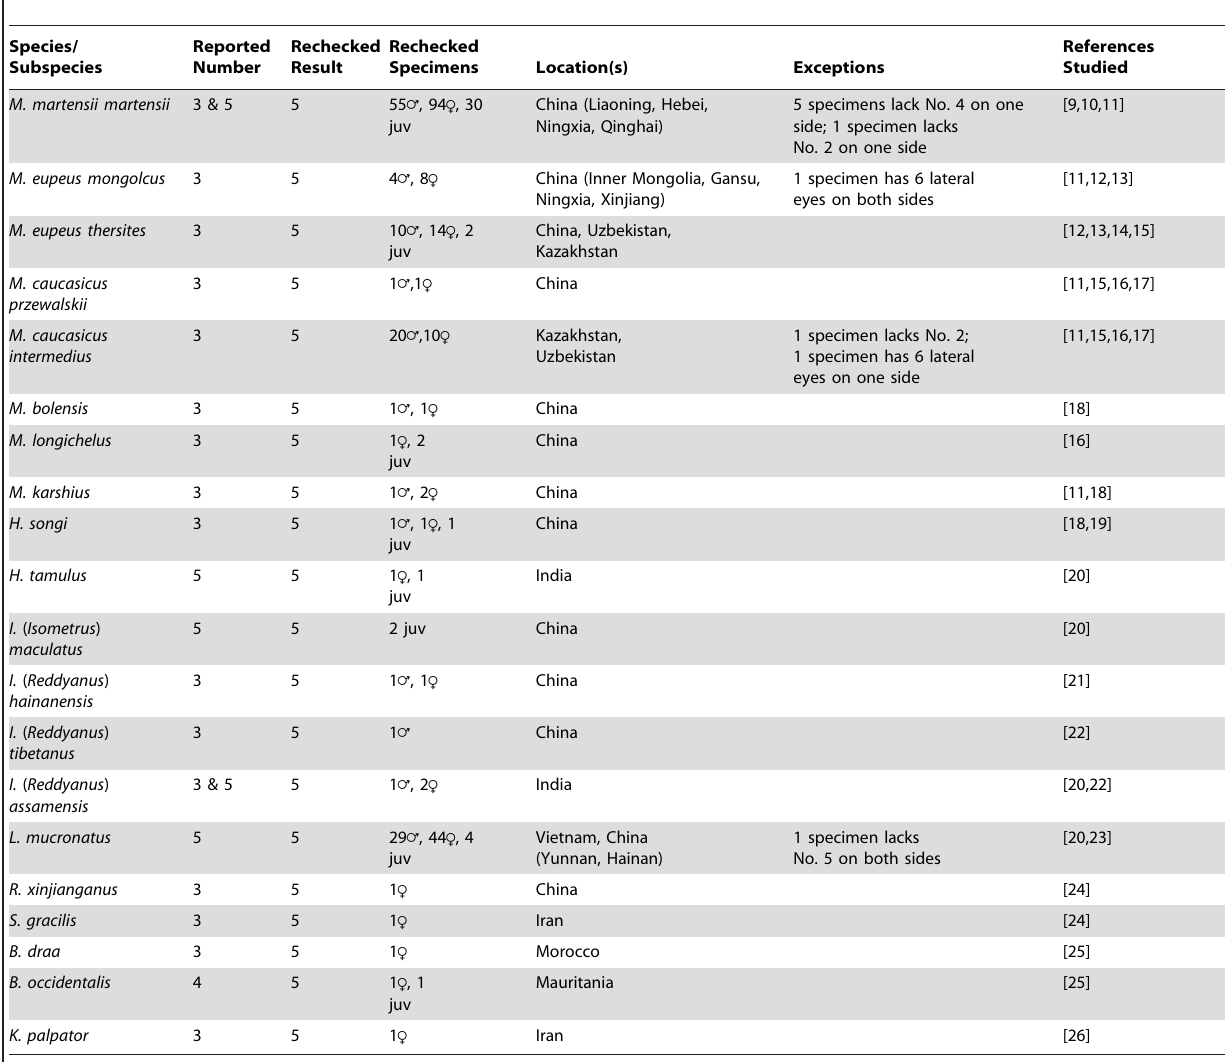
Table 1. Status Update and Statistics of Rechecked Specimens.